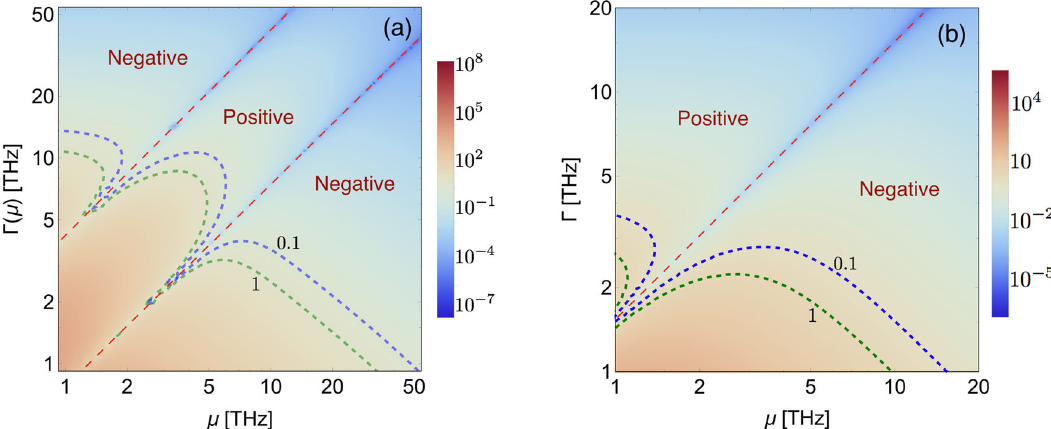
j factor with E = 1mV/nm E 2 = σ ð 1 Þ dc dc